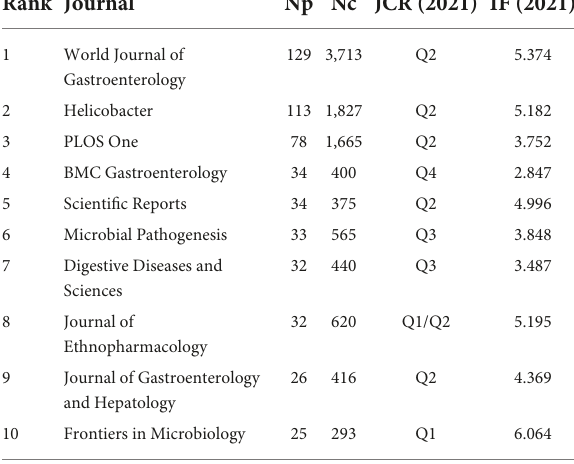
TABLE 3 Top 10 journals with the most publications in the field of Helicobacter pylori -related gastric ulcer (GU).